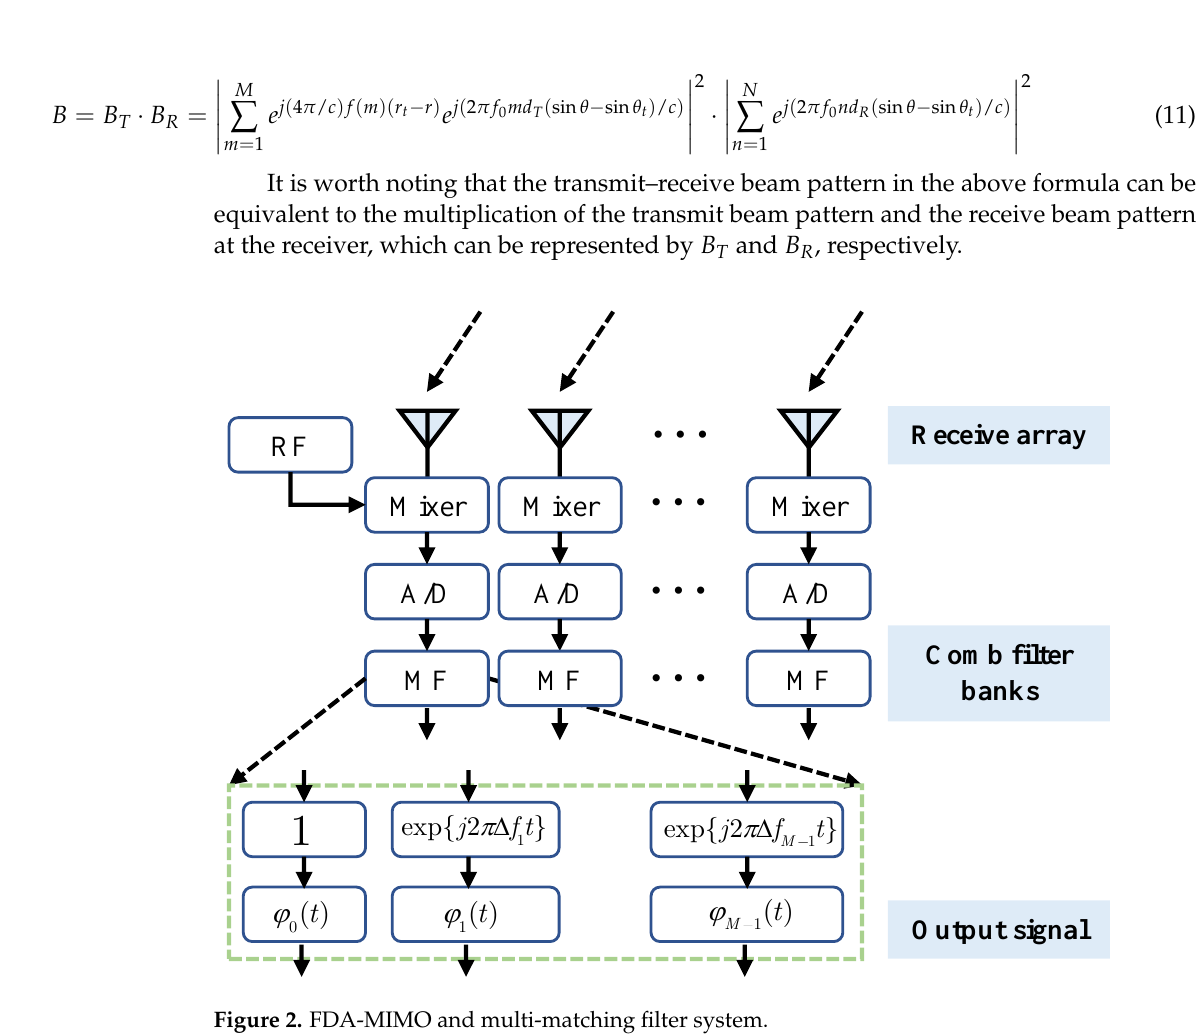
r  , the array factor AF can be expressed as tt